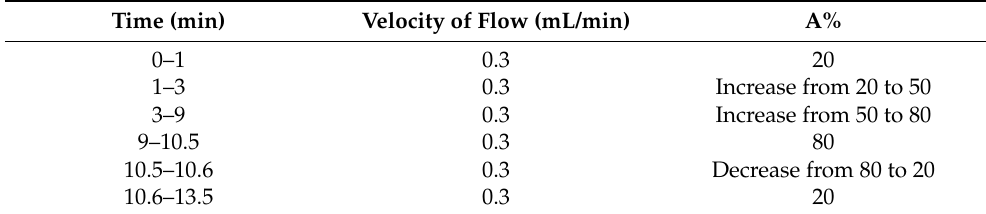
Table 3. Gradient parameters of HPLC.